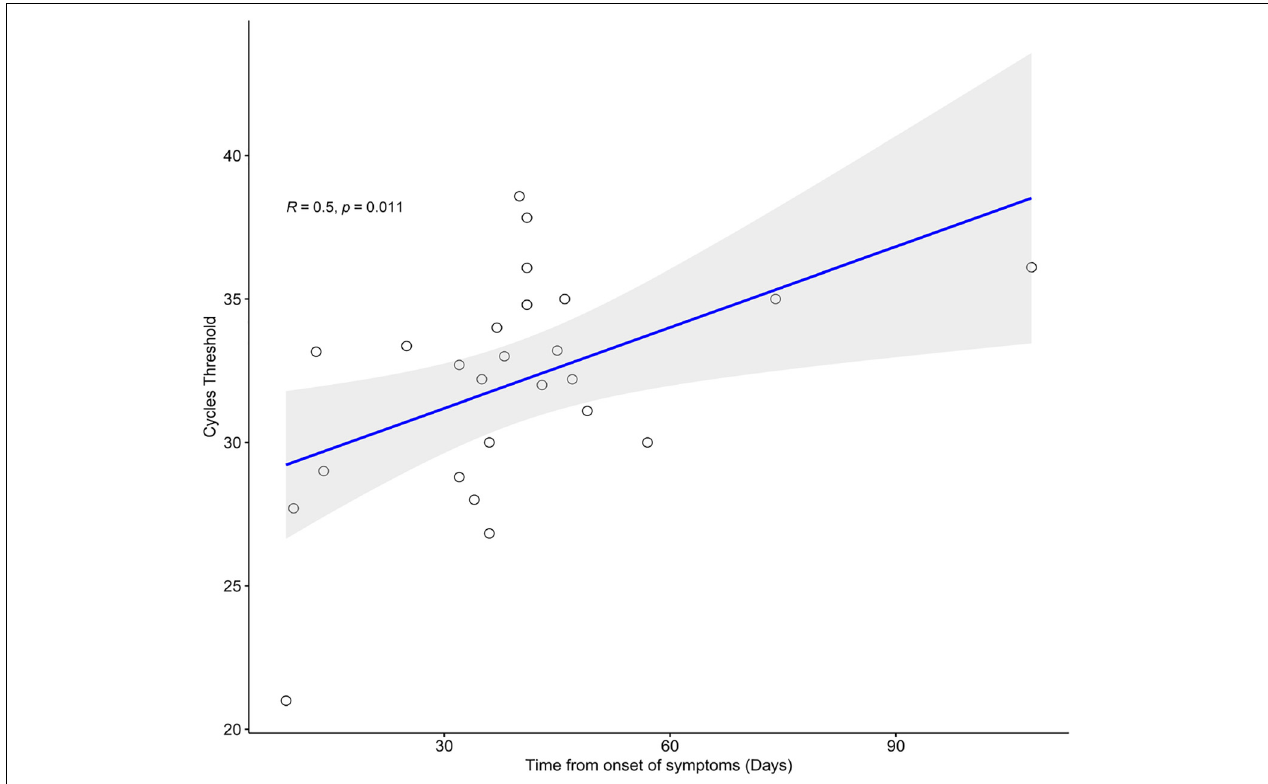
FIGURE 5 | Spearman correlation between days from onset of symptoms and SARS-CoV-2 cycle threshold values of FFPE samples, where regression line is shown in blue and confident interval in